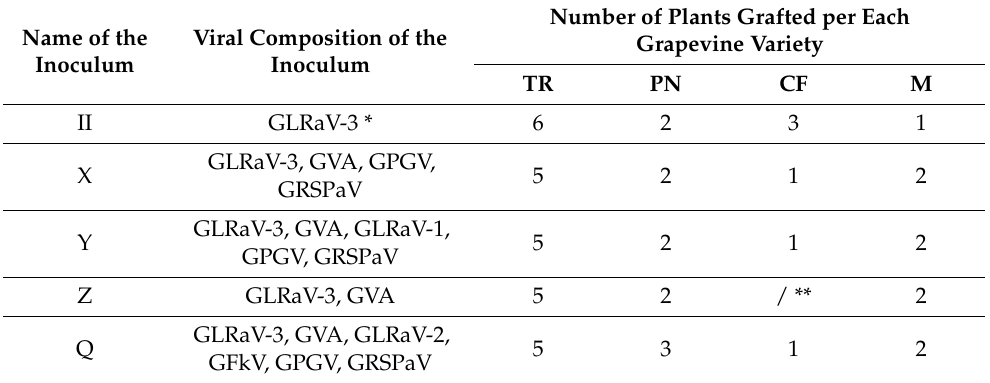
Table 1. Viral composition of different inocula along with the number of plants grafted per each grapevine variety.